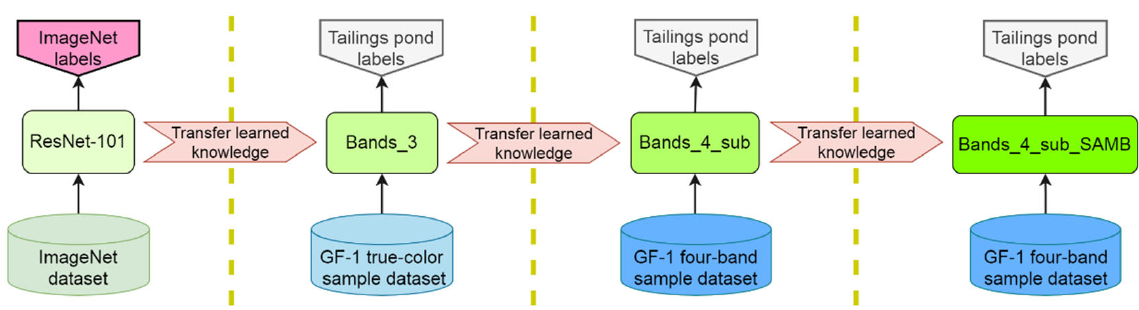
Figure 6. Step ‐ by ‐ step transfer